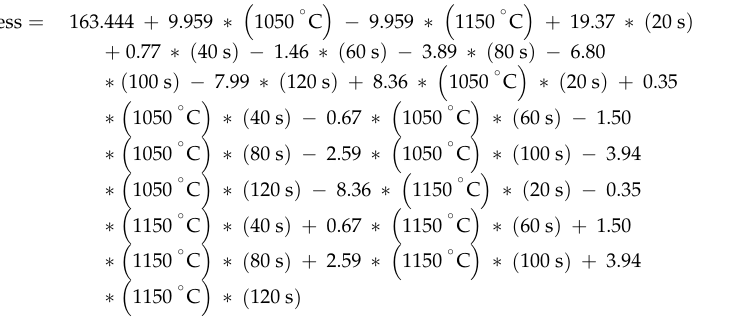
Figure 16. Effects of temperature and soaking time on hardness, computed using Minitab software. Table 4. The p -values for different parameters and interactions.